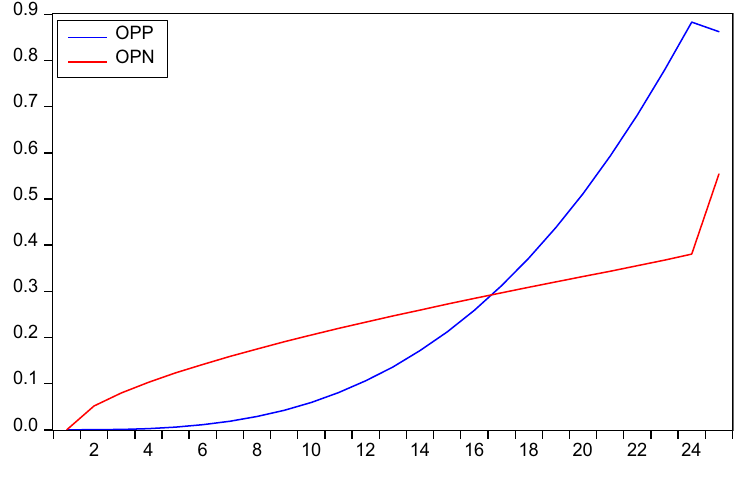
Figure 6. Thelaggedpatternsfor coefficients of OPP and OPN in the domestic oil price